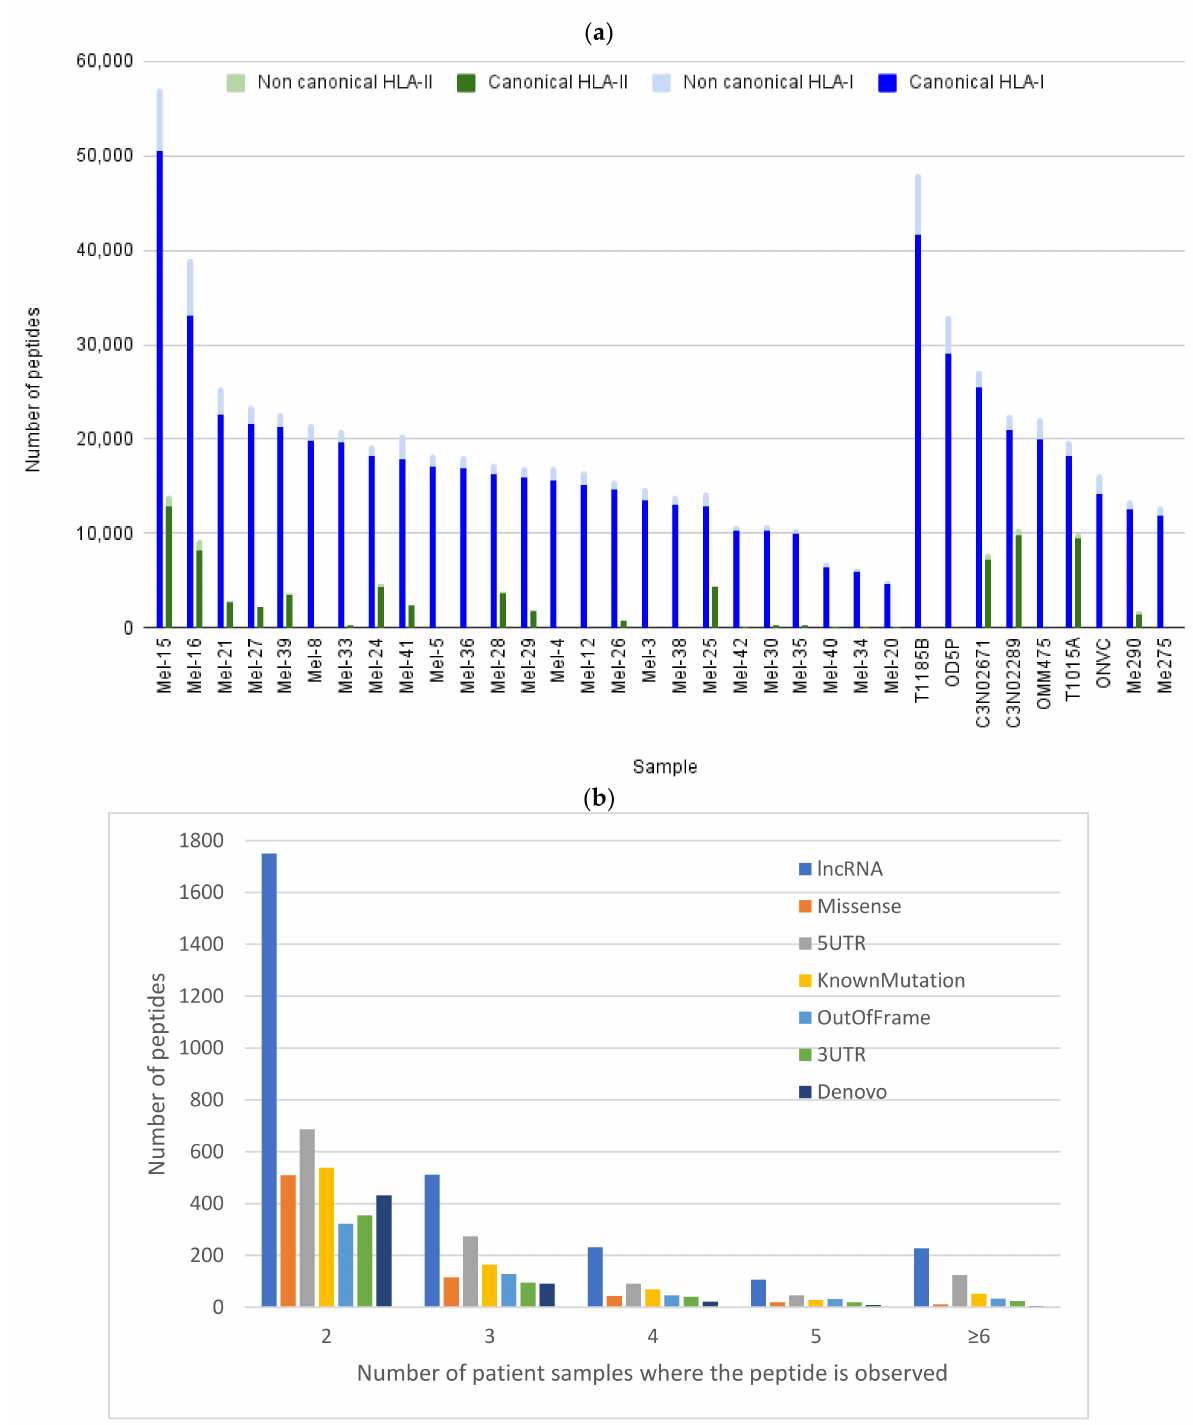
Figure 3. Comparing canonical and non-canonical peptides across the two data sets. ( a ) Distribution of canonical and non-canonical HLA-I and HLA-II peptides observed for each patient sample across the two data sets. ( b ) Number of non-canonical peptides observed in more than two patients plotted for the various types of non-canonical